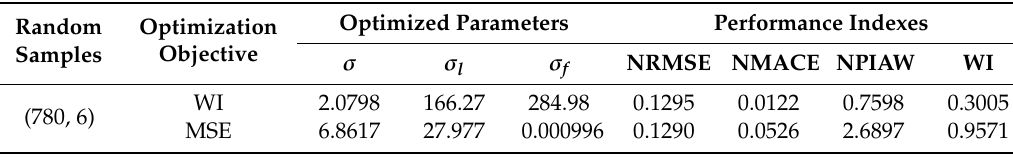
Table 2. Testing of wind speed prediction using different objectives .